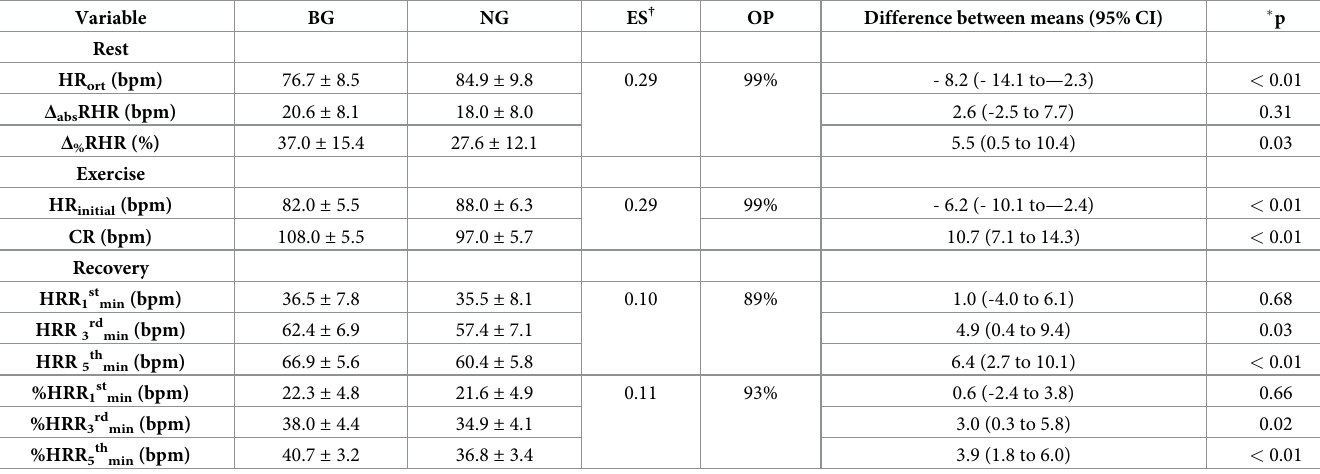
Table 2. Mean ( ± standard deviation) comparative values of the chronotropic response before, during, and after a submaximal exercise test. Variable